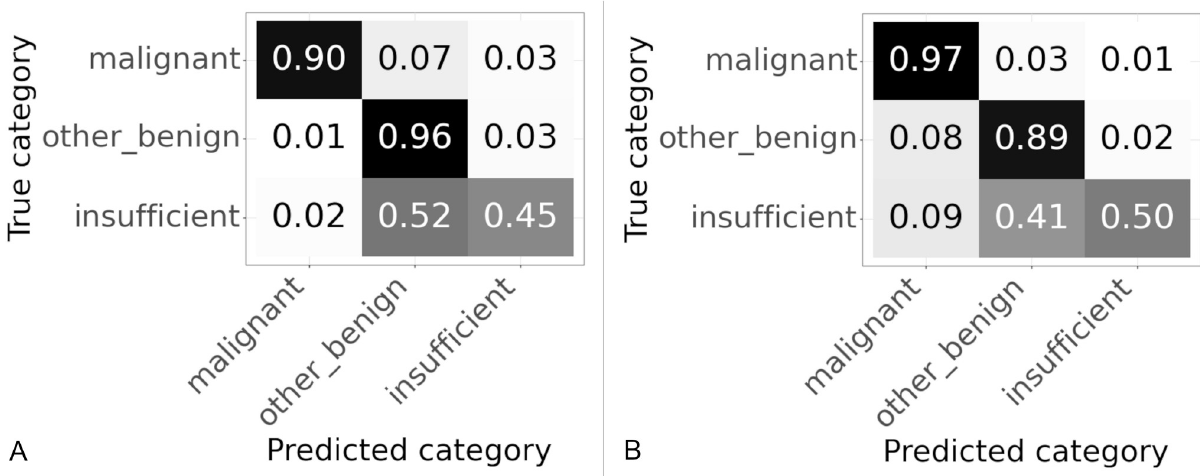
Fig 10. Confusion matrices with slide model hyperparameters tuned to give high percentage of correctly classified “malignant” slides. Results on validation set using 1024 × 1024 patches. Values are normalized over the true category. (A) Original weights, tuned for high accuracy. (B) Weights tuned for high percentage of “malignant” slides correctly categorised.